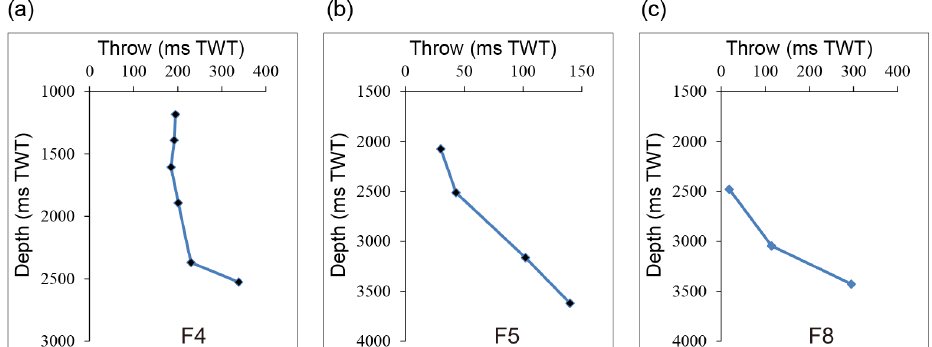
Figure 10. T – z profiles of faults F4, F5, and